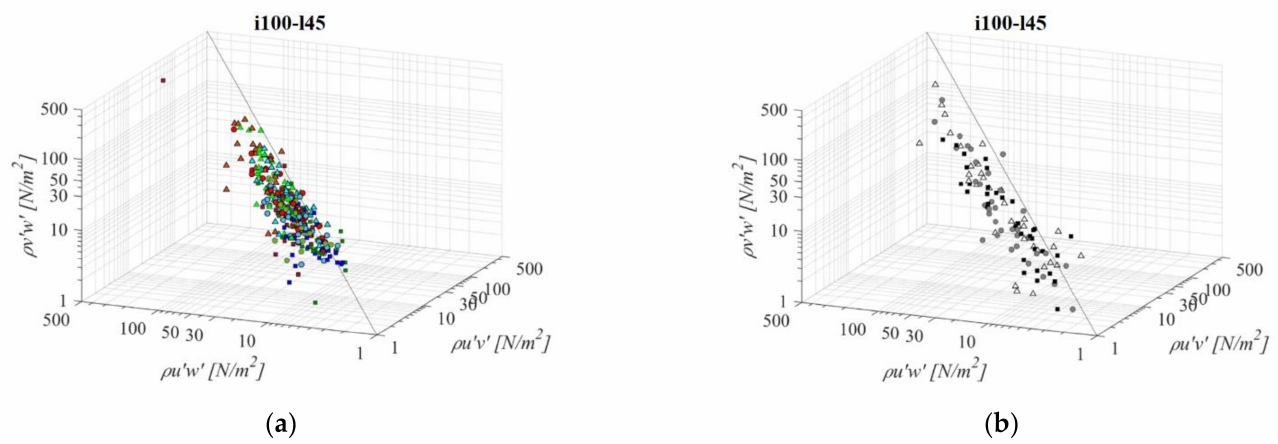
Figure 8. 3D scatterplot of concurrent RSS components for the i100l45 fishway configuration: ( a ) pool-orifice type fishway and ( b ) vertical slot